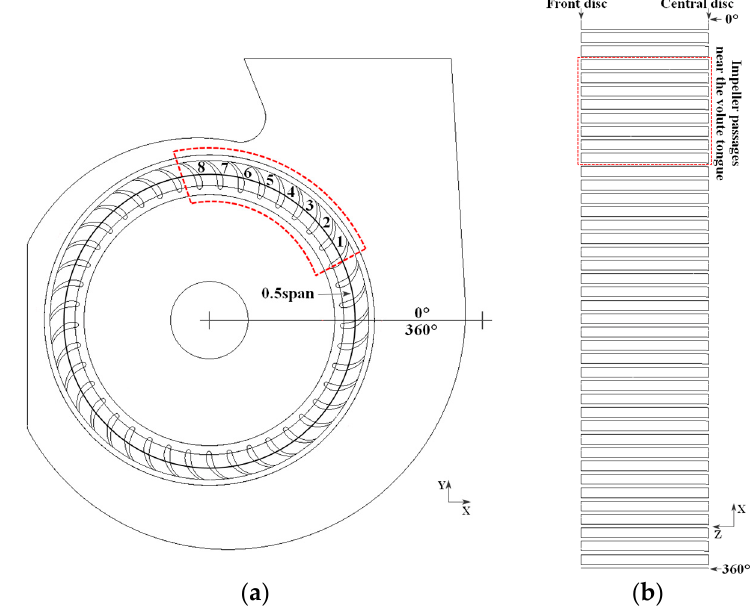
Figure 12. ( a ) Selected blade passages near the volute tongue, ( b ) the expanded view of the passages.